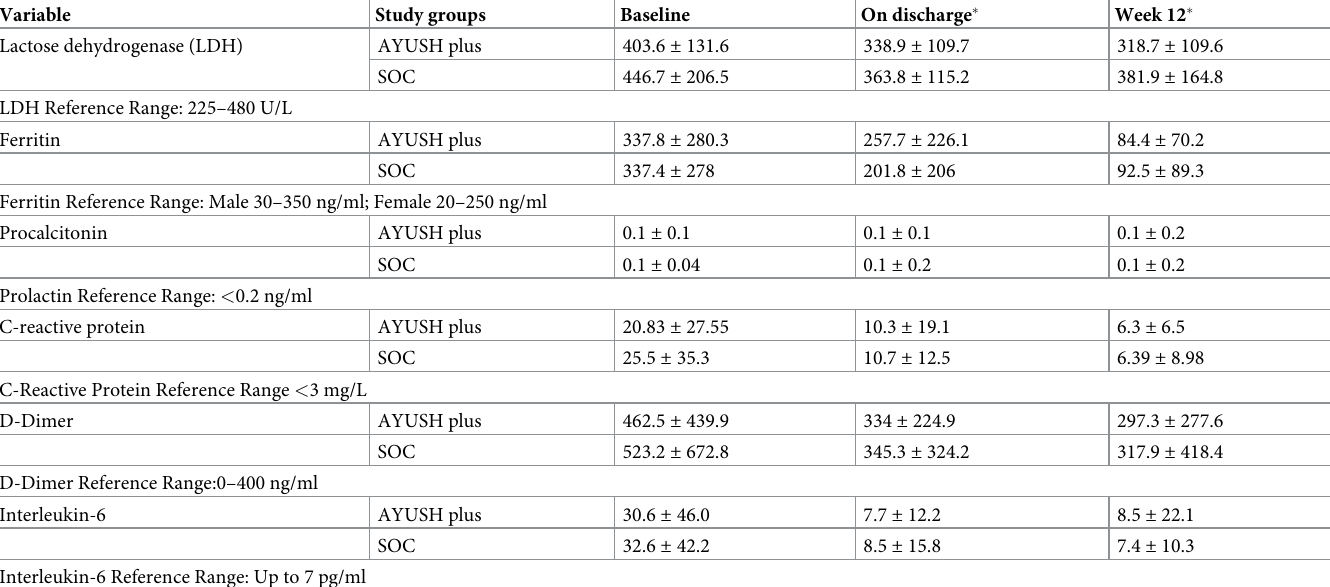
Table 3. Selected biomarkers related to COVID-19 in the two study groups (n = 139); mean (days) ± standard deviation. Variable Study groups